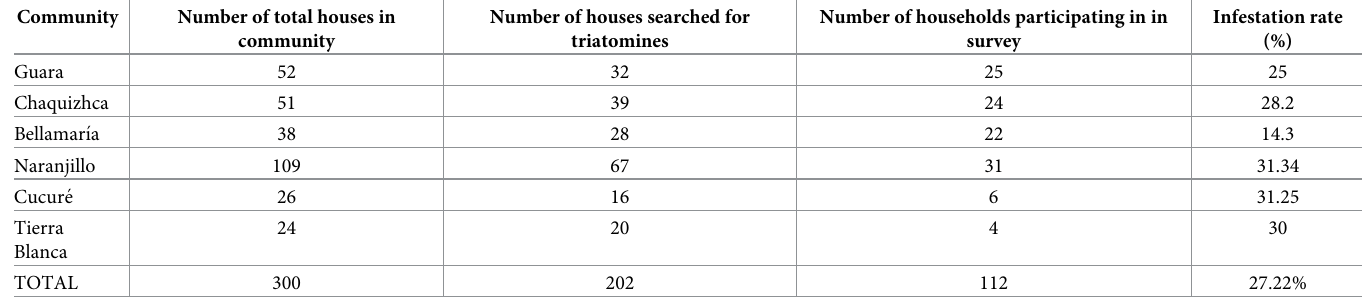
Table 1. Total number of houses, houses searched for triatomines, households participating in survey, and infestation